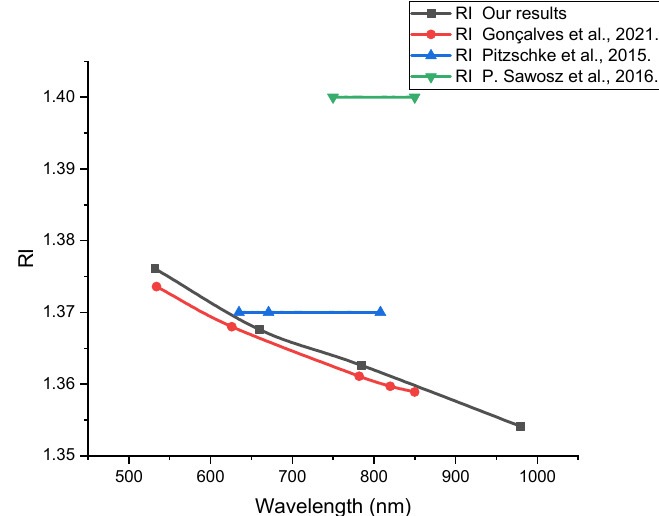
Figure 9. Wavelength dispersion of the refractive index of the rabbit brain, measured in this work (squares), data from Gonçalves et al. [29] (circles), data from Pitzschke et al. [37] (upward triangles), and data from P. Sawosz et al. [39] (downward triangles).